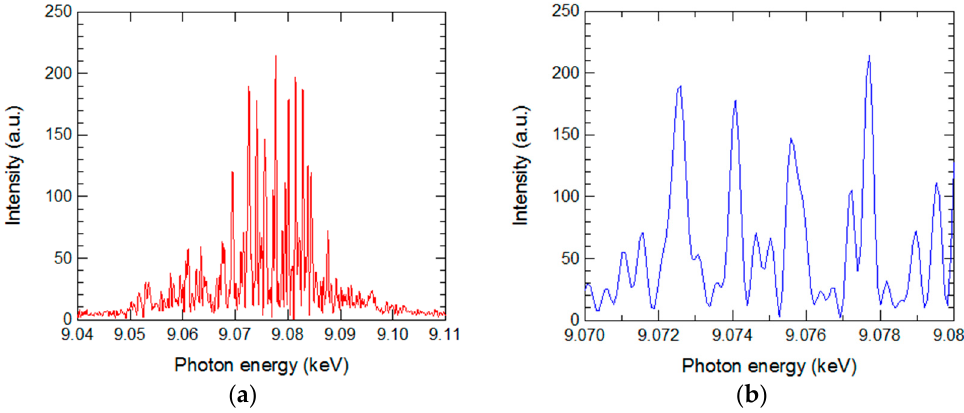
Figure 2. ( a ) Spectrum of the XFEL beam measured with the spectrometer; ( b ) enlarged spectrum around the central region of Figure 2a.